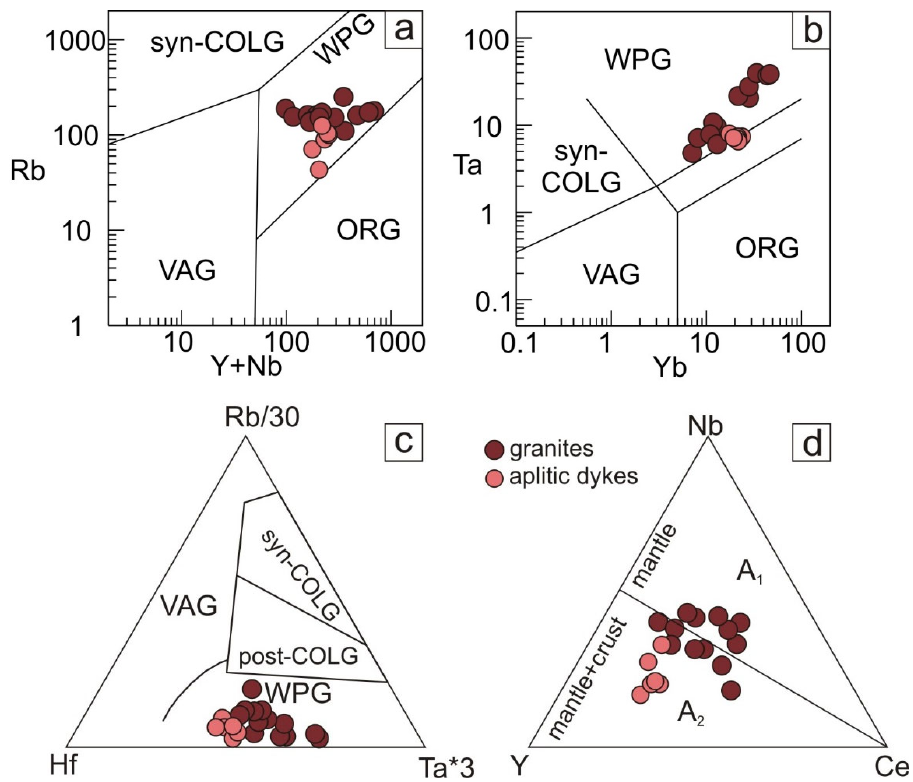
Figure 8. Tectonic diagrams for the peralkaline granitic rocks of the Tannuola terrane. ( a , b ) «Y +